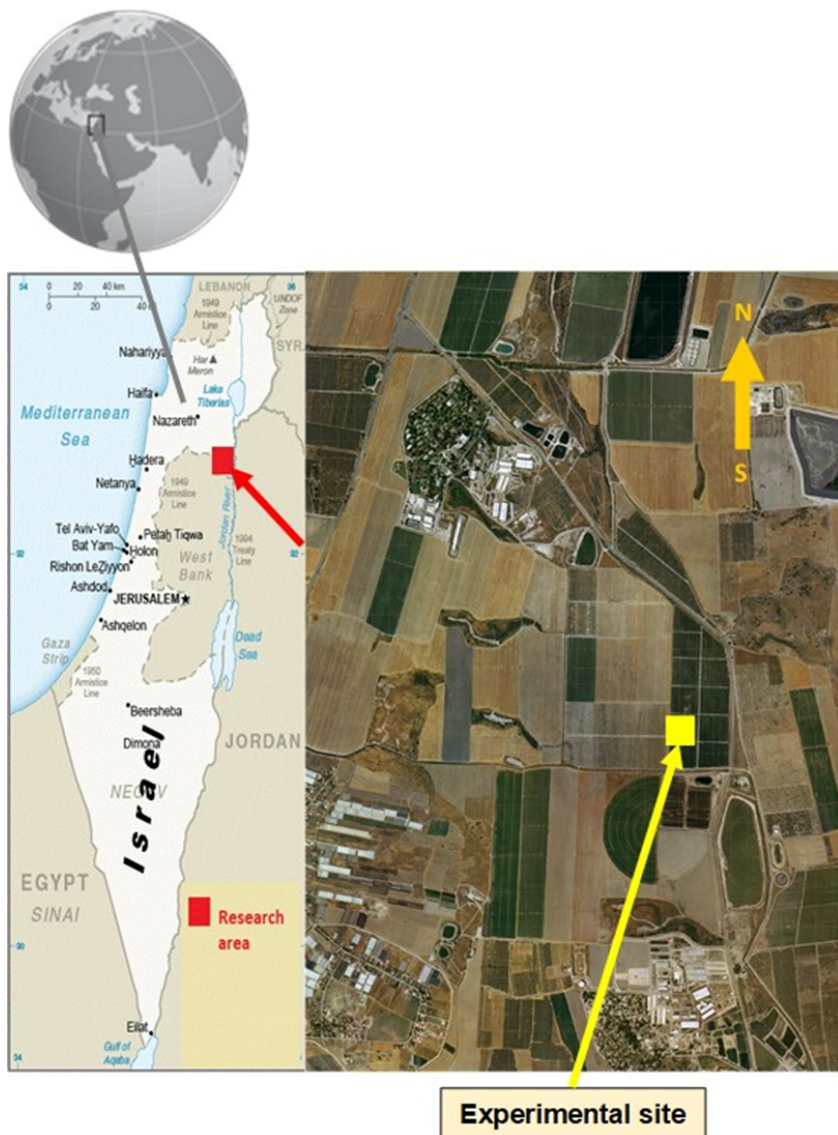
Figure 1. Study site location (regional map: after CIA factbook, 2021; photo: Survey of Israel,